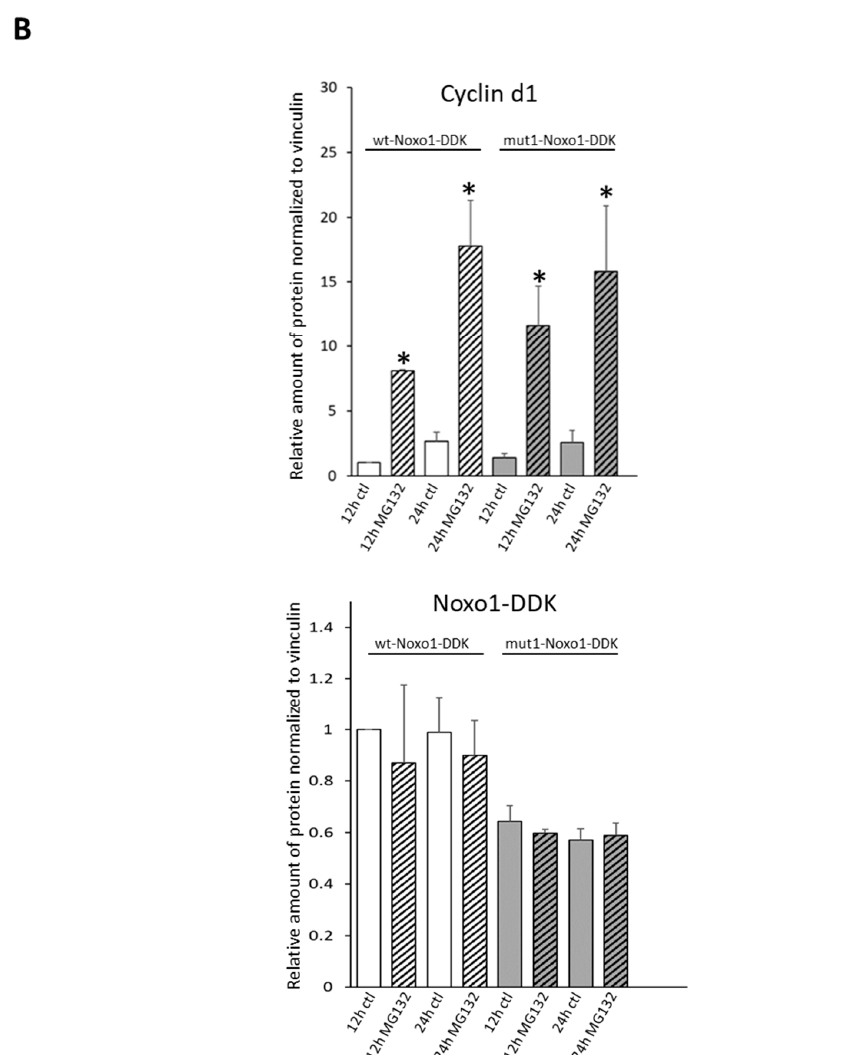
Figure 9. Noxo1-DDK stability analysis using proteasomal inhibitor MG132 in Caco-2 cells overex- pressing wt or mut1 Noxo1-DDK and lysed in Laemmli buffer. ( A ) Caco-2 cells were treated with MG132 (for 12 or 24 h, 5 µM). Immunoblot of vinculin, Noxo1-DDK, and cyclin d1. Vinculin was used as the loading control, and cyclin d1 was used as the positive control for proteasomal degradation. ( B ) Quantification of immunoblots for cyclin (upper panel) and Noxo1-DDK (bottom panel). Results represented mean +/ − S.E.M normalized to ctl vinculin using the untreated 12 h time point as reference. * p < 0,05 compared without MG132.